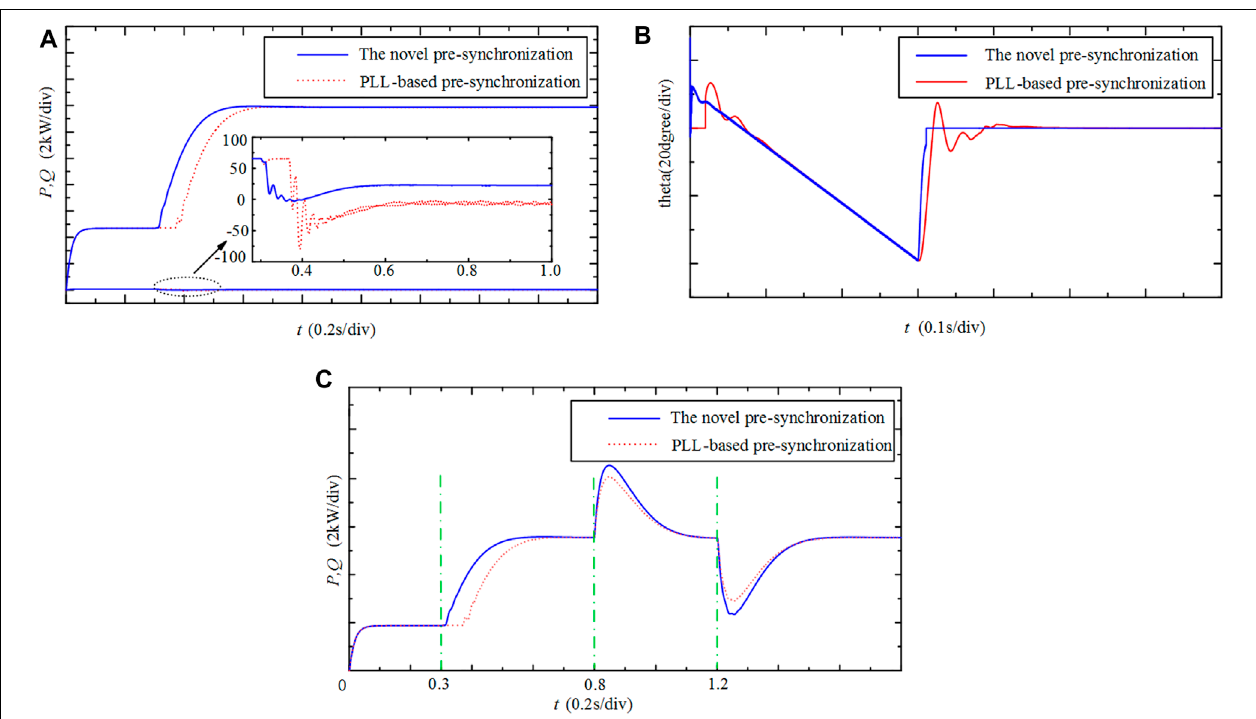
FIGURE 9 | Comparison result of two pre-synchronization methods: (A) the power changed; (B) the theta changed; (C) power variation under multiple grid